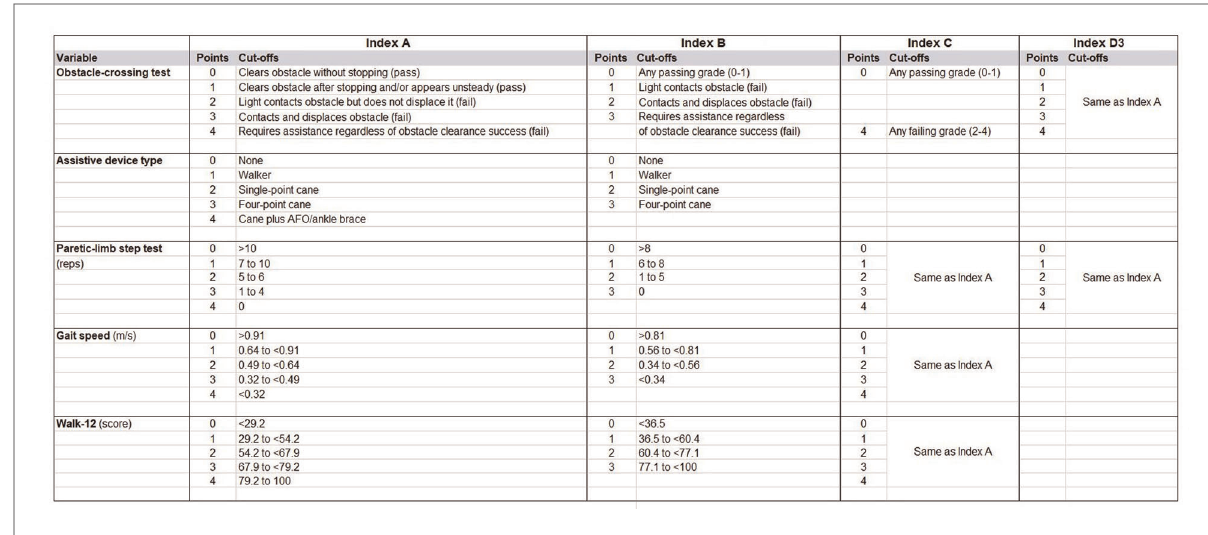
FIGURE 1 Composite index variations with cut-offs for each item.